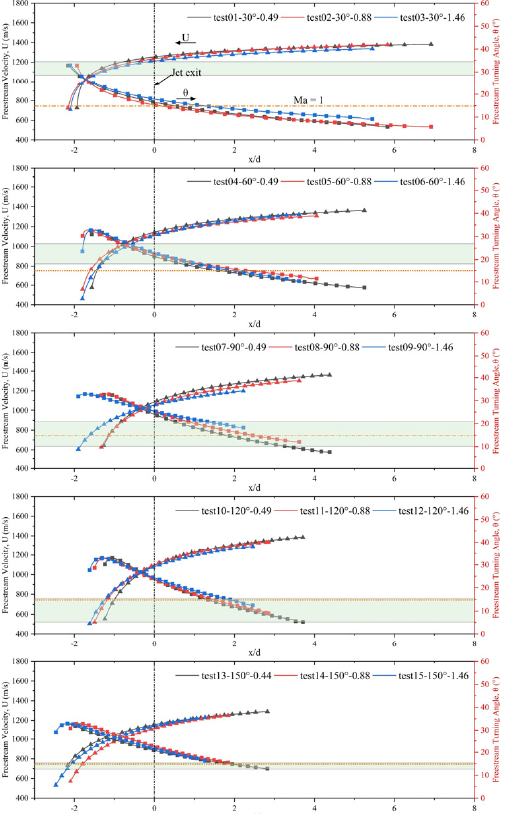
Figure 14. Velocity and deflection angle of the mainstream behind the bow shock. In Figure 14, the orange dots and lines represent the velocity when Ma = 1. In addi ‐ tion, the green boxes represent the regions with y/d between 1 and 2 for the same jet angle